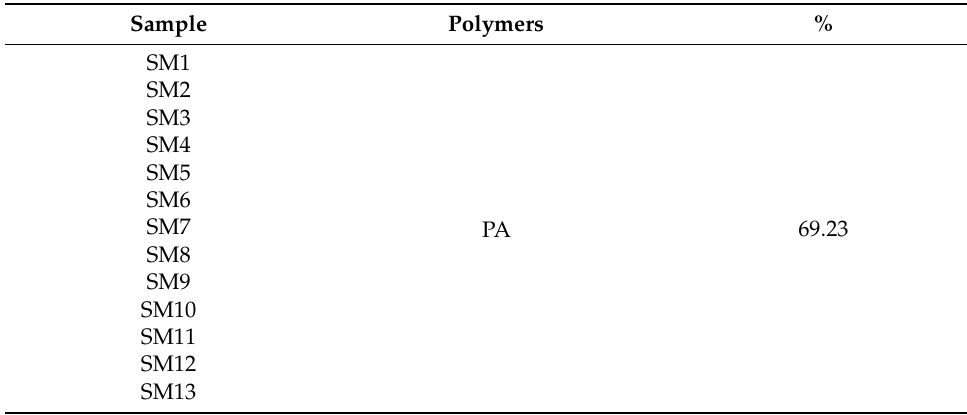
Table 2. Polymers identified by FTIR-ATR in mussel samples.